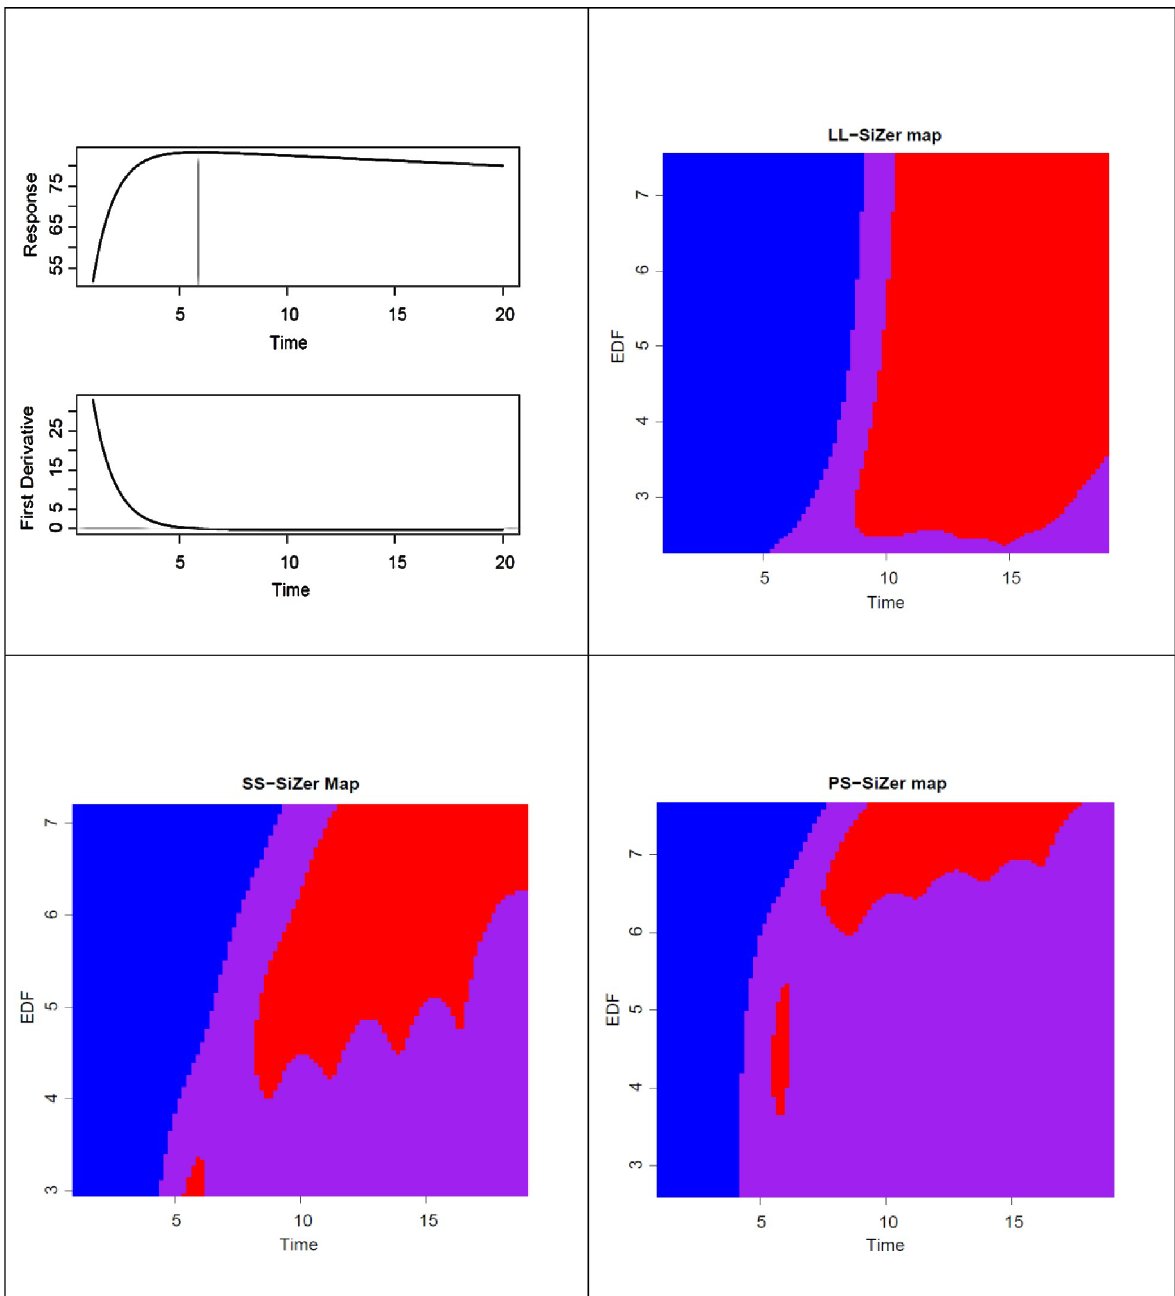
Fig 3. Simulation study 2. Upper-left panel: True function and first derivative; Upper-right panel: LL-SiZer map; Lower-left panel: SS-SiZer map; Lower-right panel: PS-SiZer map. The vertical axis represents the 100 levels of EDF and the horizontal axis represents the time.